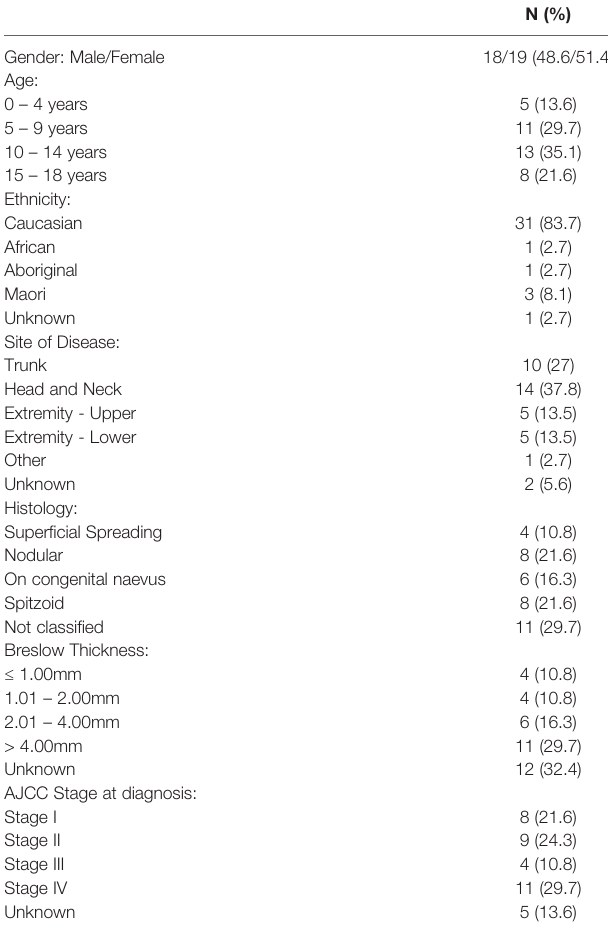
TABLE 1 | Patient characteristics and Clinical Features of the 37 patients with malignant melanoma in Australia and New Zealand 1 st January 1995 – 31